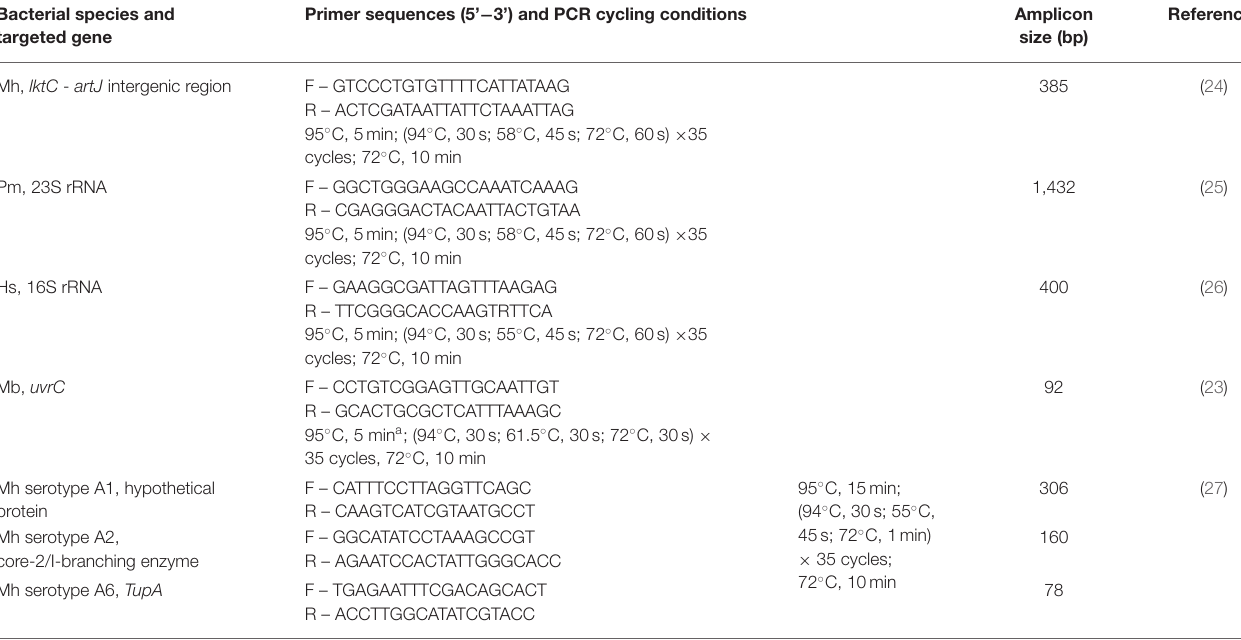
TABLE 1 | Oligonucleotide primers, PCR protocols, and amplicon sizes for each PCR assay used in this study. Bacterial species and targeted